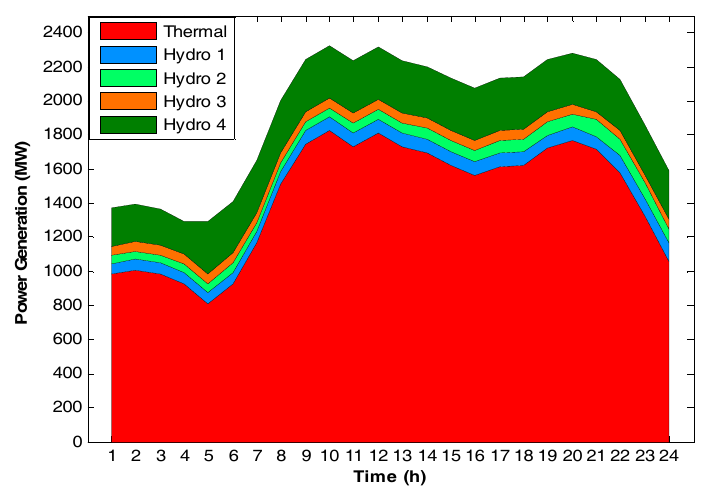
Figure 4 . Hourly hydro and thermal plant generations for test system 1, case 1. Figure 4. Hourly hydro and thermal plant generations for test system 1, case